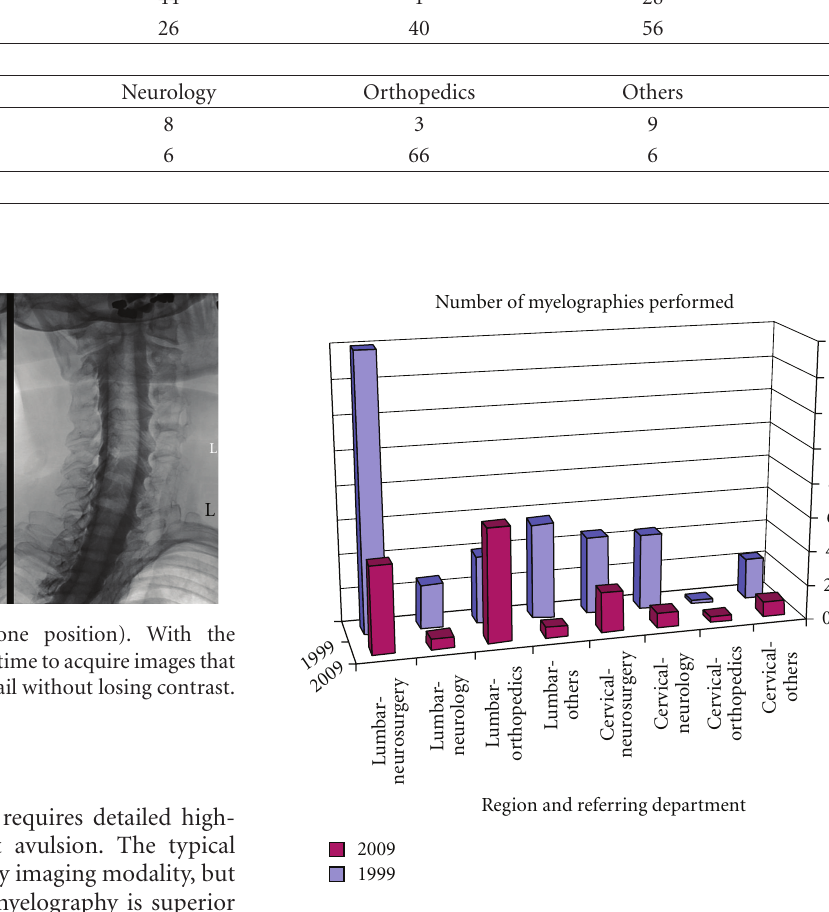
Figure 6: Development of myelography exams at the authors’ institution